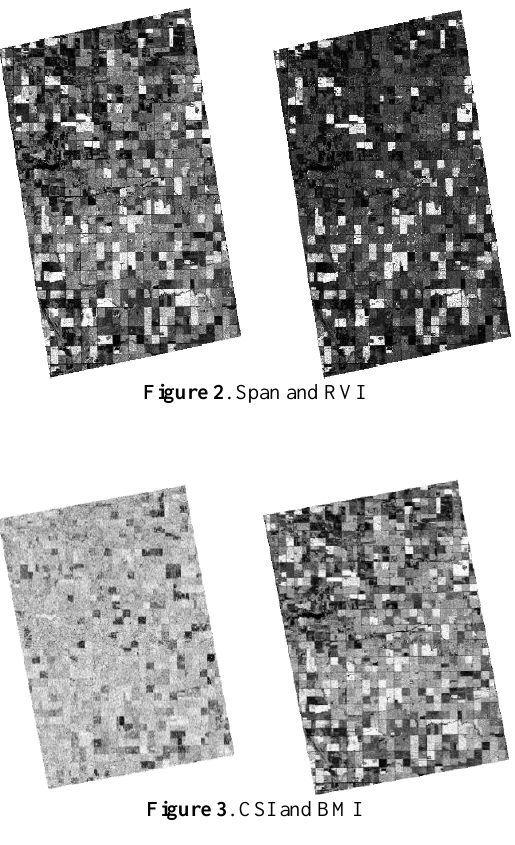
Figure 3 . CSI and BMI